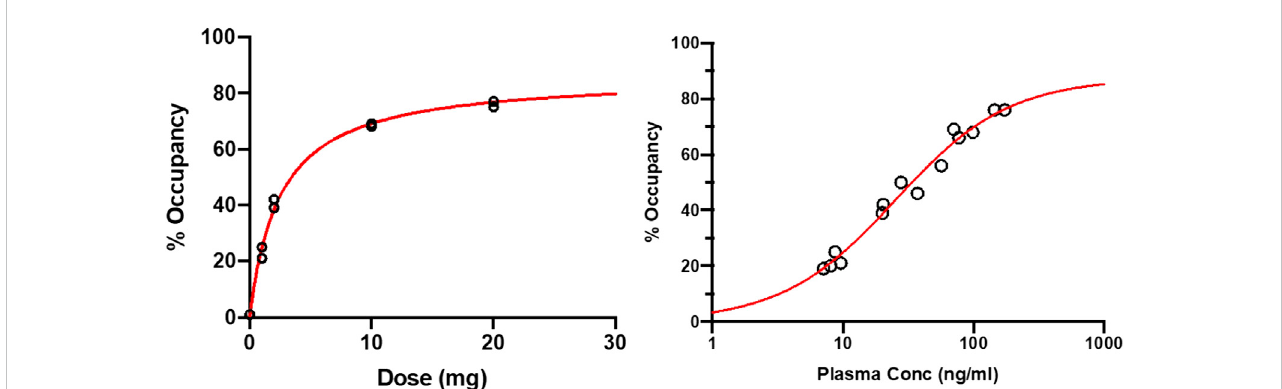
FIGURE 3 Target occupancy by plasma concentration and dose based on 11 C-UCB-J PET measurements around T max and 24 h post-dose (left) Dose-occupancy relationshipat T